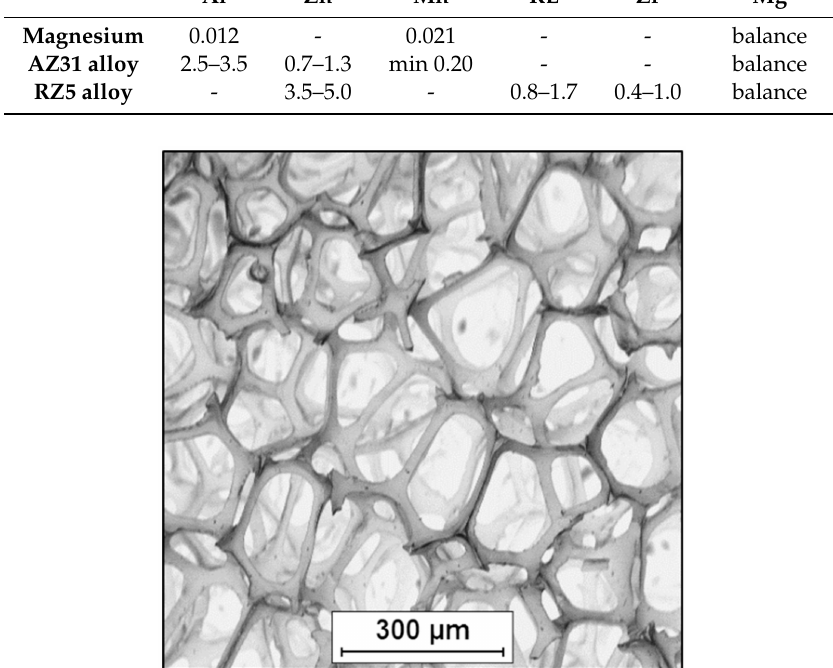
Figure 1. SEM micrograph of Duocell reticulated vitreous carbon foam C of of 100